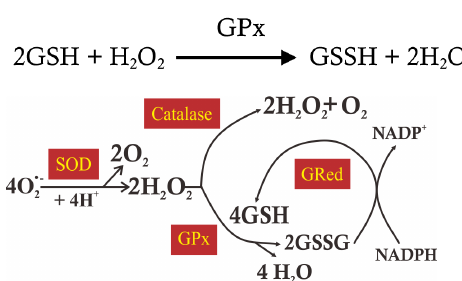
Figure 1. Role of SOD, catalase and GPx in eliminating ROS (Kunwar,